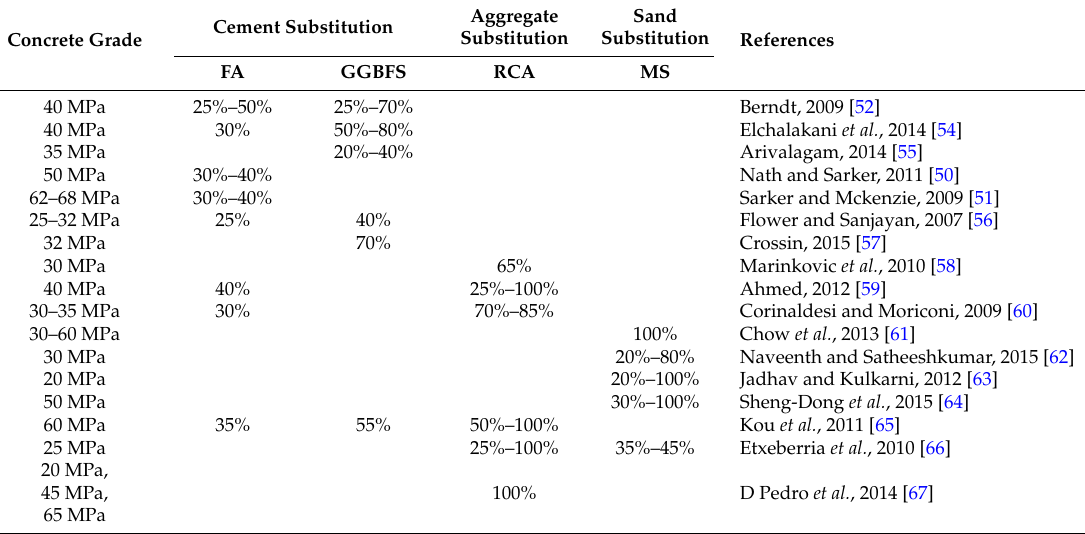
Table 2. Percentage replacements of concrete constituents considered for various